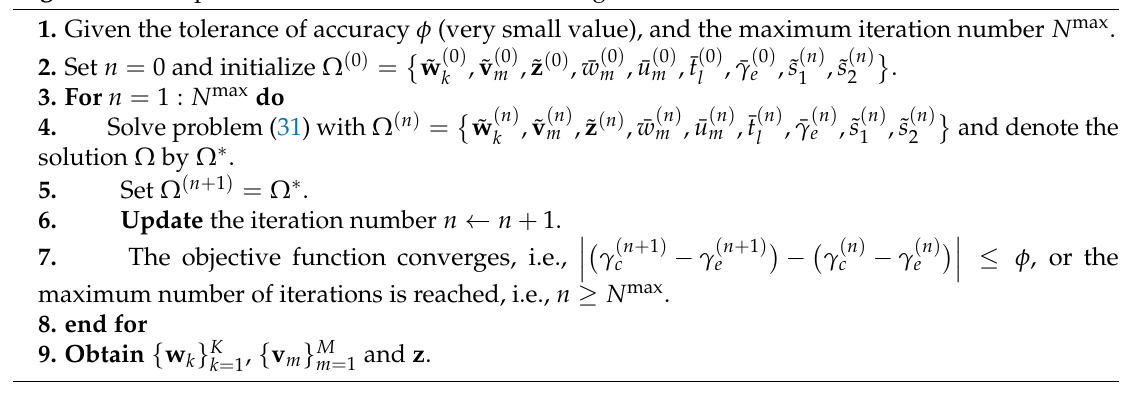
Algorithm 1 Proposed SCA-SPCA-based iterative Algorithm